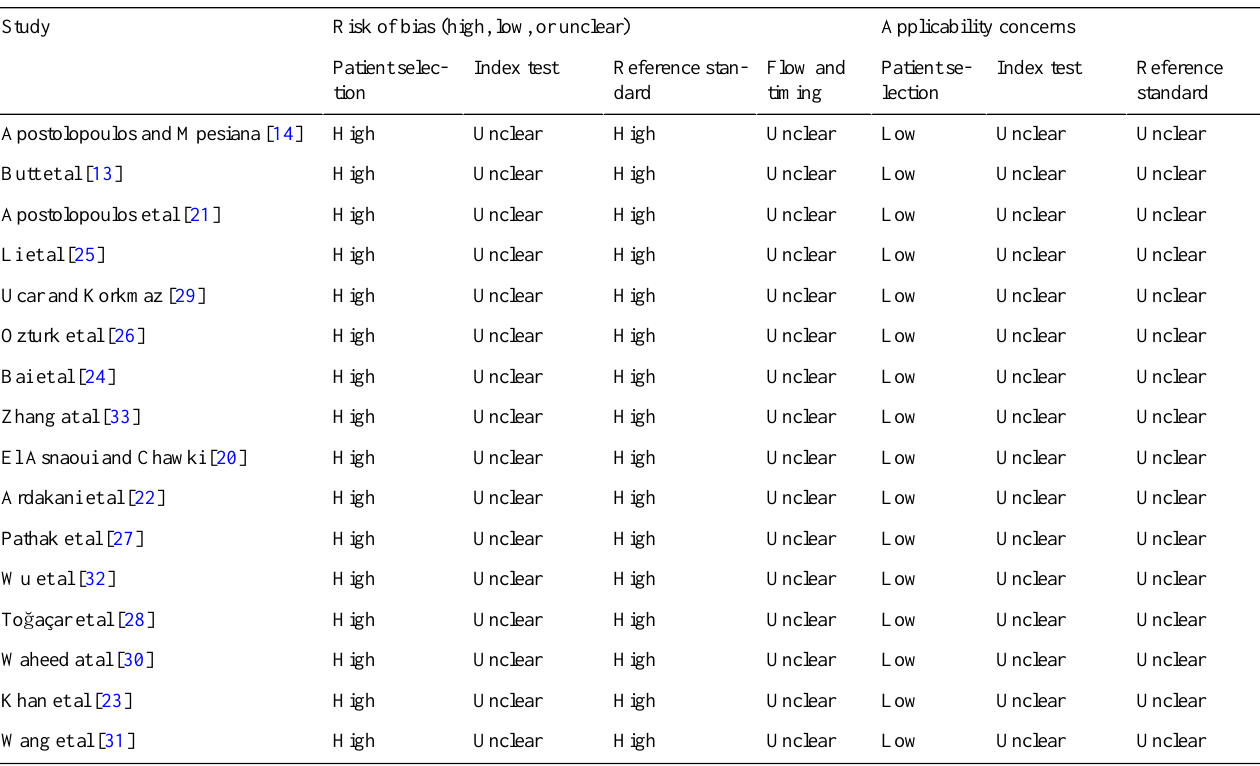
Table 3. Quality Assessment of Diagnostic Accuracy Studies-2 for included studies.